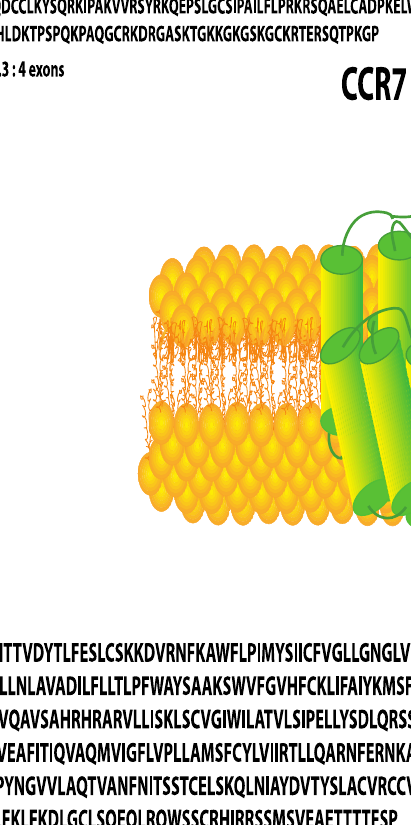
Figure 1. CCR7 (Uniprot Available (https://www.uniprot.org/uniprot/P32248) P32248 (accessed on 2 February 2022) [amino acids 25–378]) and its ligands CCL19 (Uniprot Available (https://www.uni-